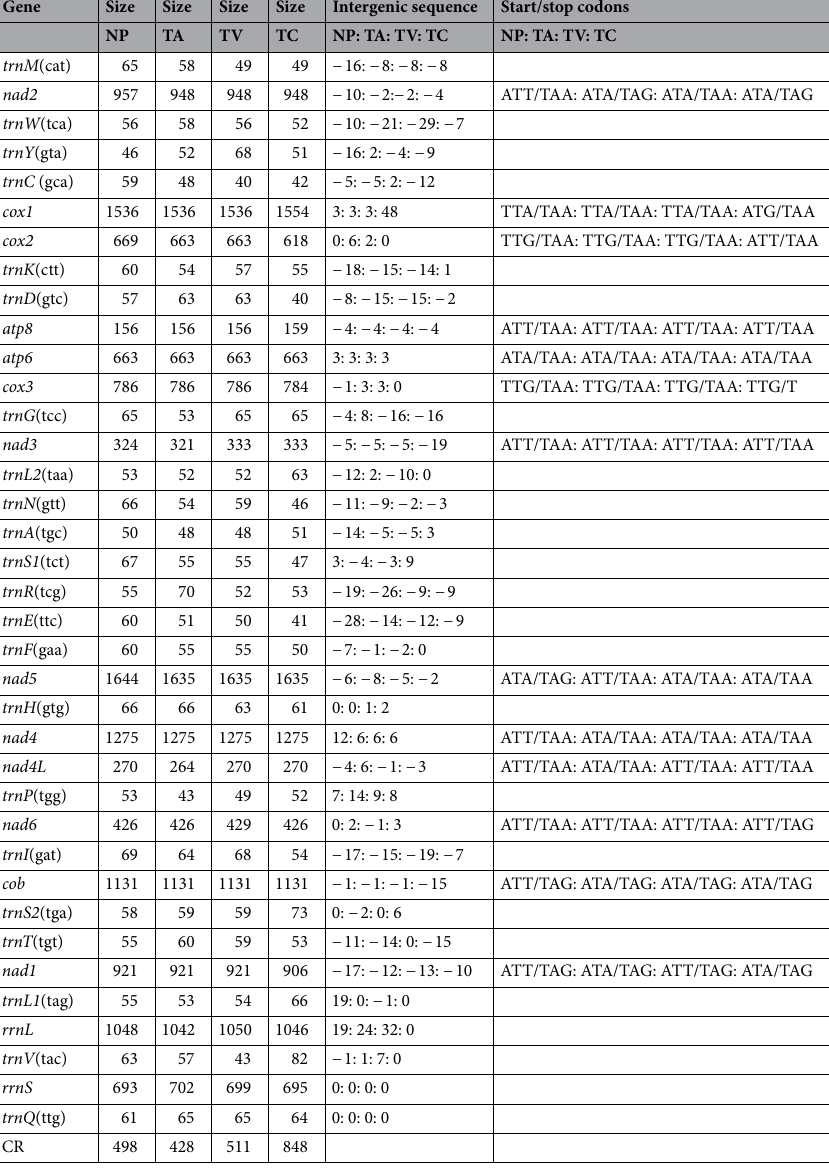
Table 1. Gene order and features of mitochondrial genome of Nephila pilipes (NP), Trichonephila antipodiana (TA), Trichonephila vitiana (TV, previously N. vitiana ) and Trichonephila clavata (TC, NC_008063). CR, control region; size in bp; minus sign indicates